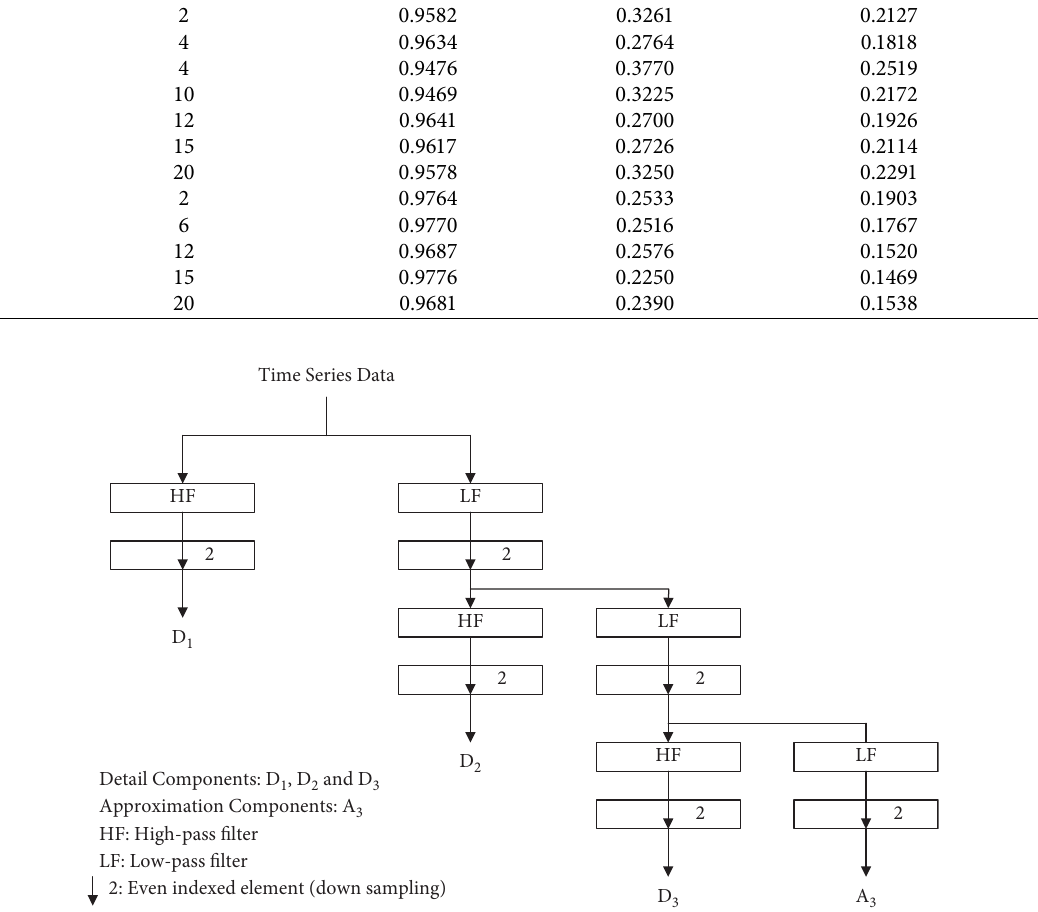
1 , D 2 , and D 3 ) and approximation component ( A 3 ).